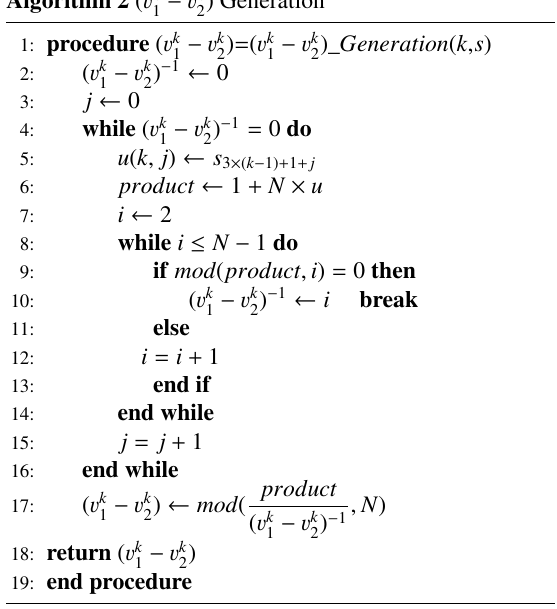
Algorithm 2 ( v k